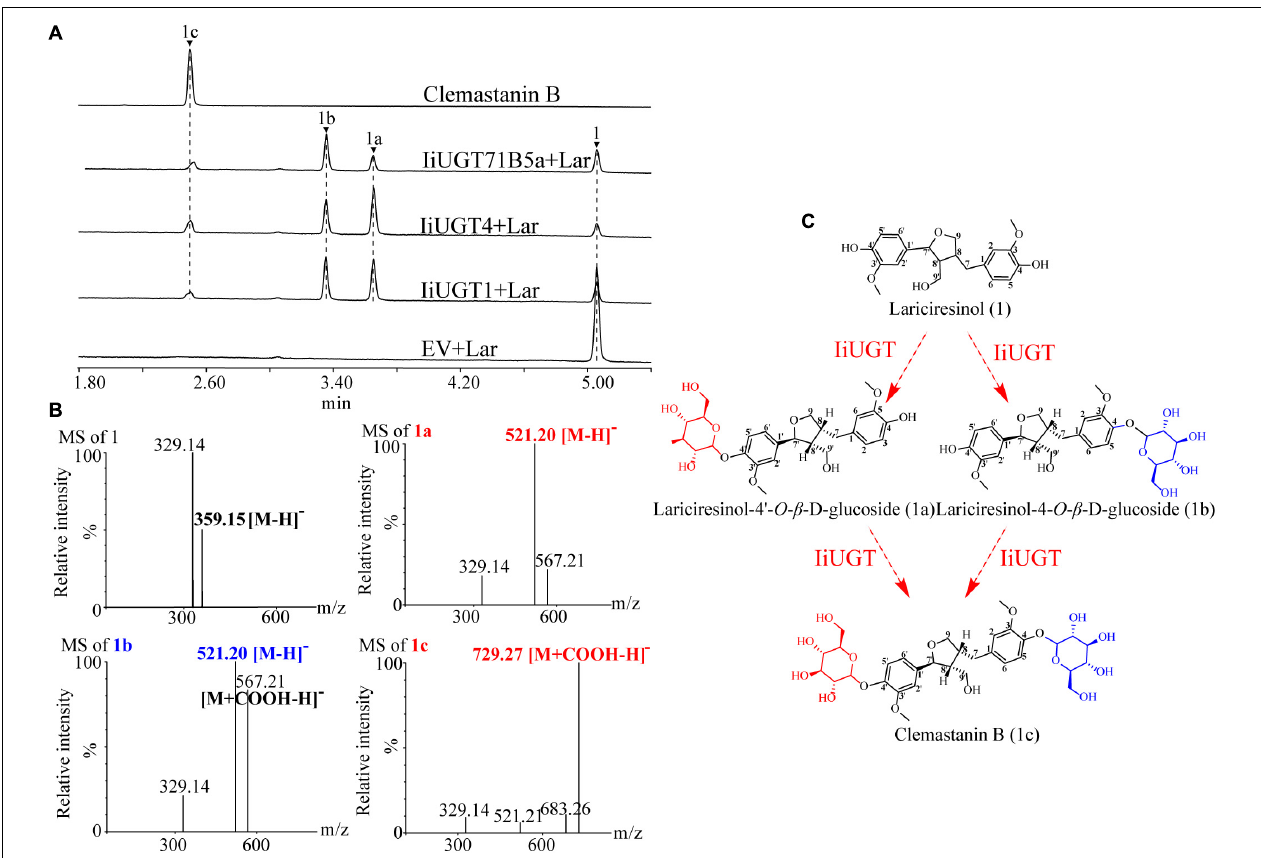
FIGURE 3 | The hypothetical biosynthetic pathway for clemastanin B in I. indigotica and functional characterization of candidate IiUGT proteins. (A) UPLC/Q-TOF-MS analysis of candidate IiUGT enzymatic reaction products against lariciresinol. The enzyme reactions of crude proteins of E. coil carrying empty vector (EV), IiUGT1, IiUGT4, IiUGT71B5a were assayed with UDP-glucose as the sugar donor and Lar (lariciresinol) as the sugar acceptor. (1) lariciresinol; (1a) lariciresinol-4 (cid:48) - O - β -D-glucoside; (1b) lariciresinol-4- O - β -D-glucoside; (1c) clemastanin B. (B) MS spectra of the products in negative mode. (C) A